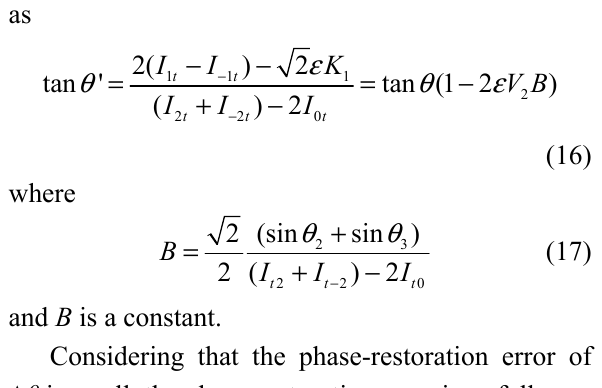
Fig. 2 Shearing phase in the simulation.